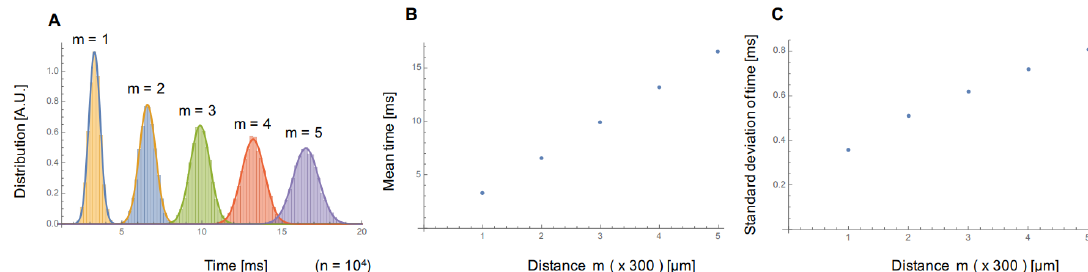
Figure 5. Simulation results of conduction time distribution in the faster firing regulation model. Histogram ( A ), mean value ( B ), and S.D. ( C ) of propagation time acquired from the one way random walk model ( n = 10 3 , mean propagation time 3.3 µm/s, and S.D. 0.36 µm/s). The distribution of